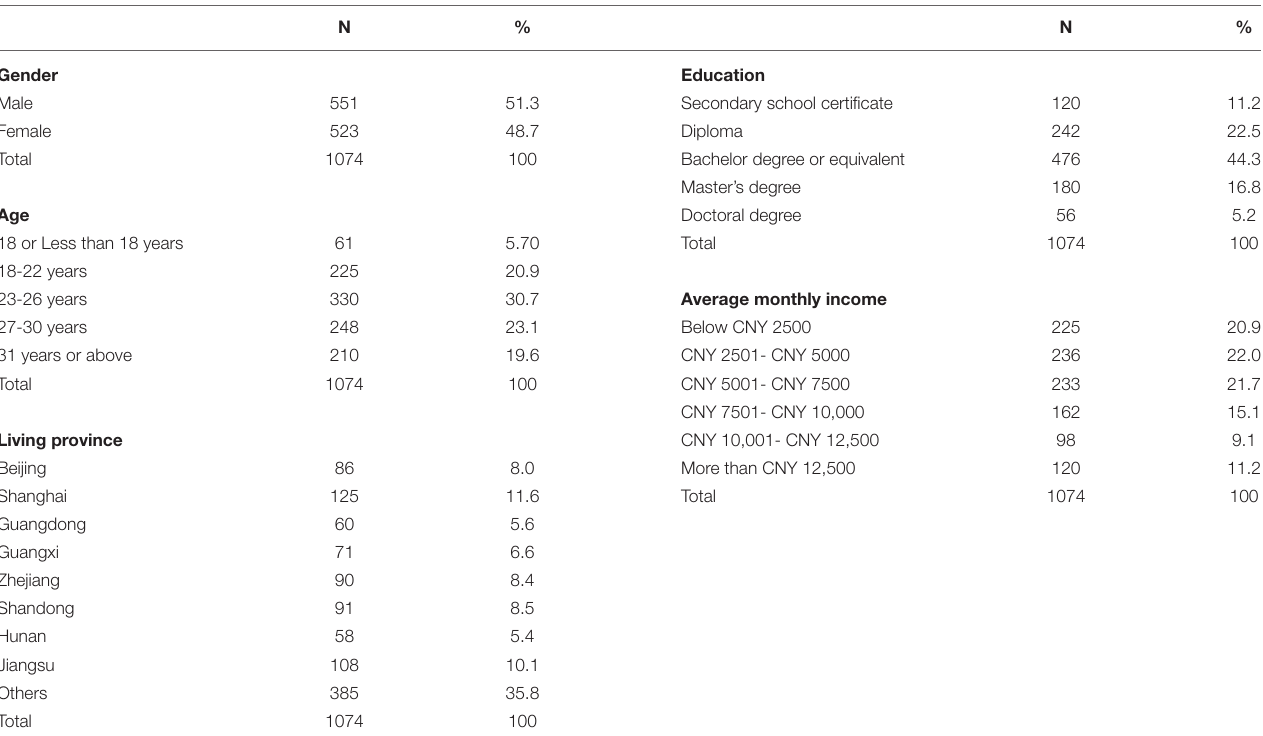
TABLE 1 | Demographic